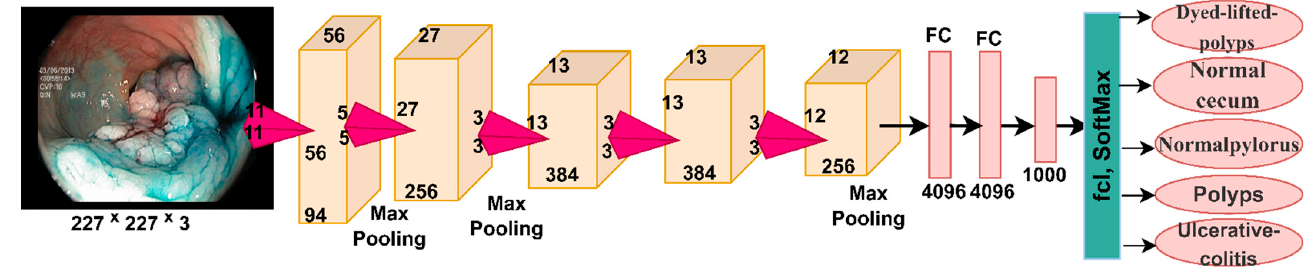
Figure 7. General structure of the AlexNet model for classifying the lower GI endoscopy image dataset.